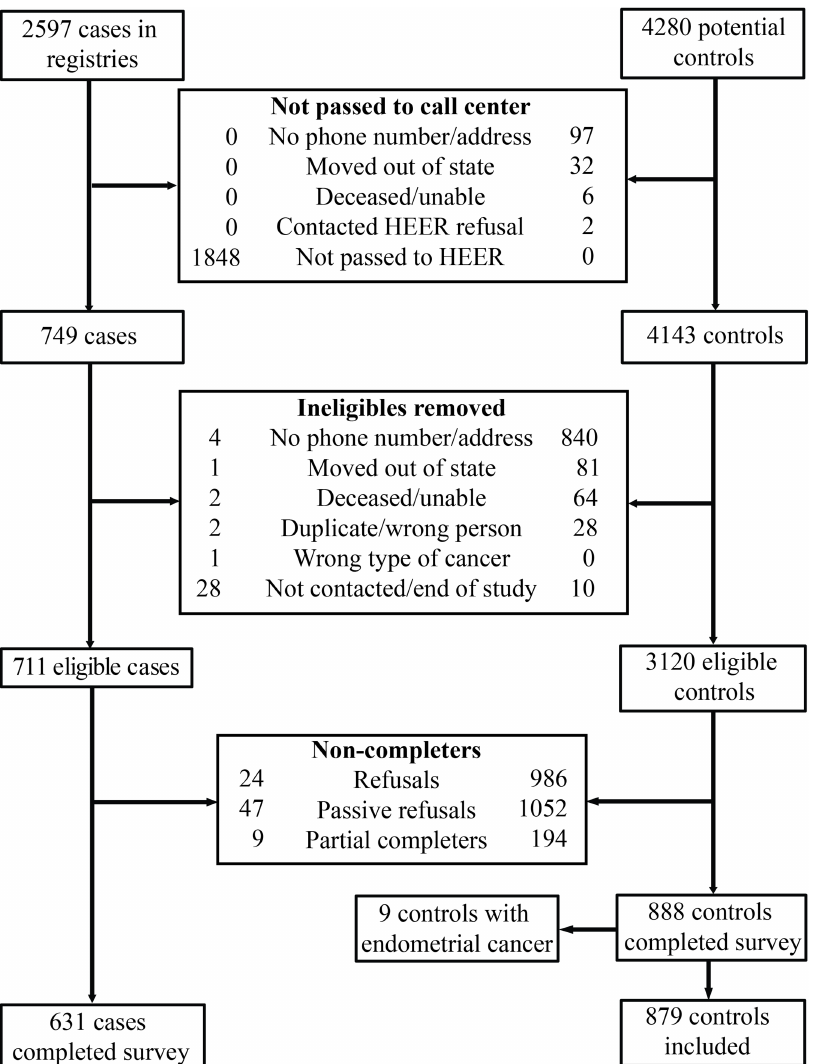
Fig 1. Exclusion and enrollment of participants in the Health and Environmental Exposure Research